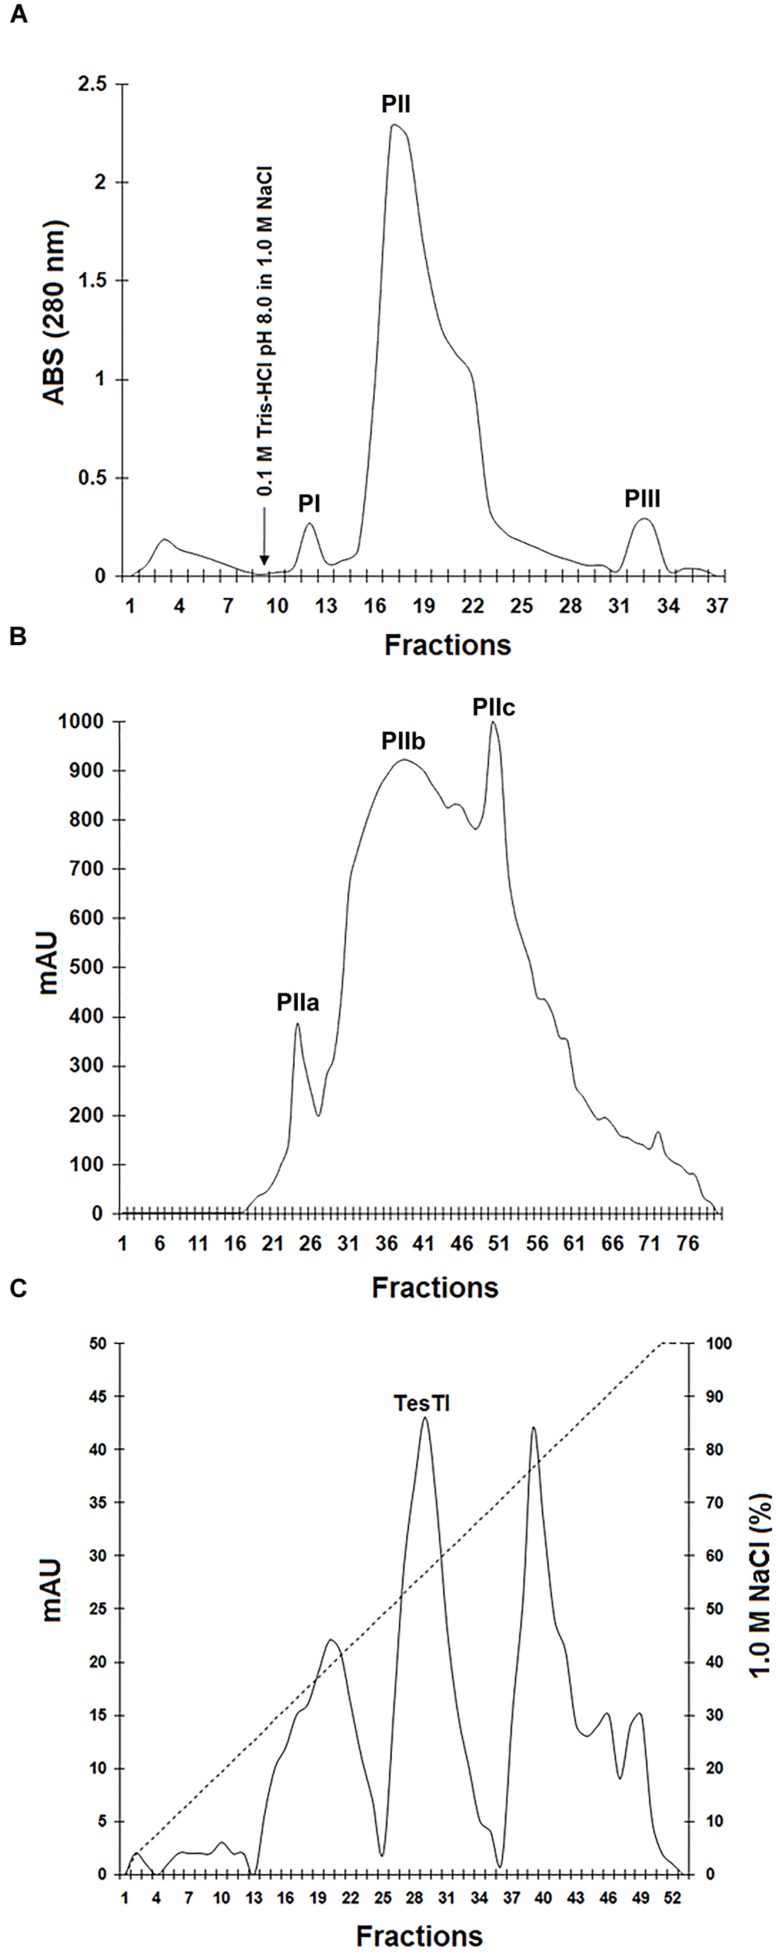
Purification of trypsin inhibitor from Tecoma stans leaves (TesTI). (A) Chromatography of precipitate fraction (obtained after treatment of leaf extract with ammonium sulfate) on a DEAE-cellulose column. Washing was performed using 0.1 M Tris-HCl pH 8.0. The arrow indicates the time of addition of the eluent (1.0 M NaCl). PI: fractions 11–13; PII: 15–27; PIII: 32–33. (B) Gel filtration chromatography of PII (from DEAE-cellulose column) on HiPrep 16/60 Sephacryl S-100HR column coupled to the ÄKTAprime plus chromatography system. Three pools were separated: PIIa (fractions 22–27), PIIb (28–47) and PIIc (48–58). (C) Chromatography of PIIa in the ion exchange DEAE FF 16/10 column coupled to the ÄKTAprime plus system and equilibrated with 0.1 M Tris-HCl pH 8.0. The elution step was performed using a 1.0 M NaCl gradient (0–100%). TesTI corresponded to the pool of fractions 26–33, eluted with 50–64% of 1.0 M NaCl. Chromatographies were monitored by measuring the absorbance at 280 nm.